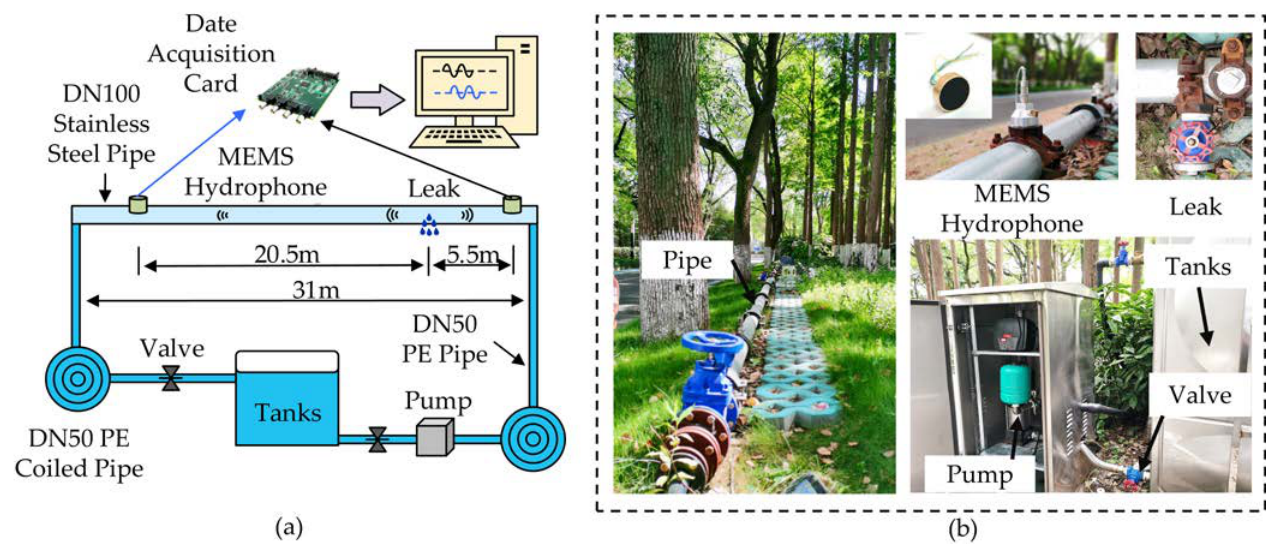
Figure 6. Details of the test pipeline system: ( a ) schematic diagram of the test pipeline system, ( b ) real picture of the test pipeline system.